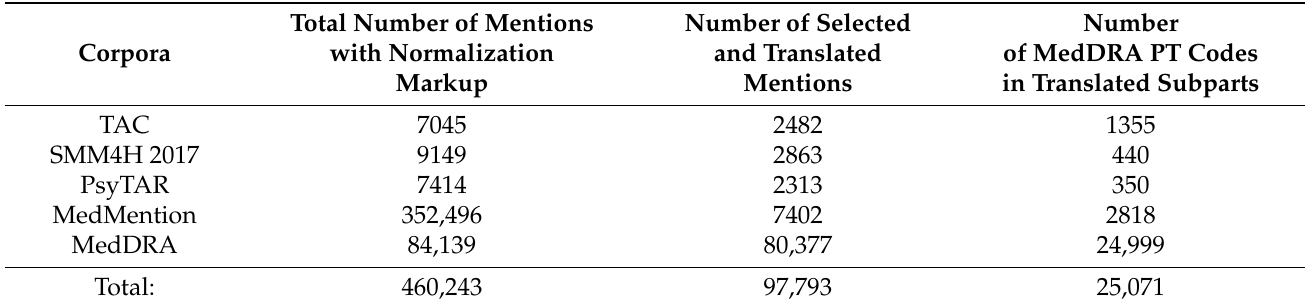
Table 3. Features of the extended